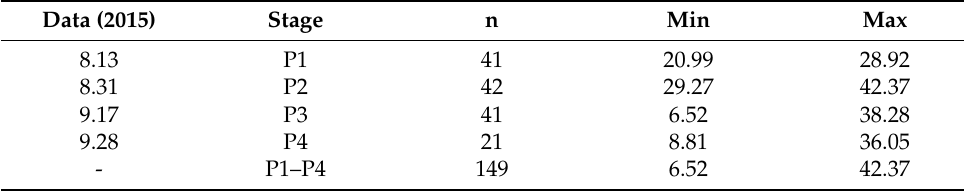
Table 1. Results of soybean LCC field measurements (Dualex